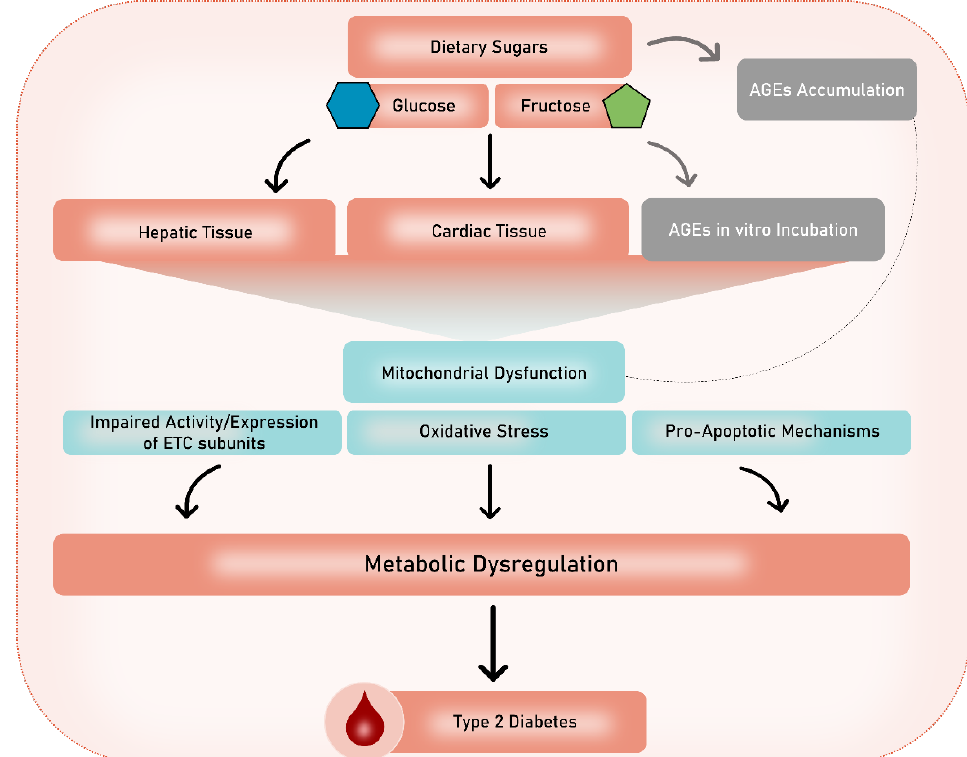
Figure 2. Increased intake of dietary sugars (mainly glucose and fructose) leads to mitochondrial dysfunction. Mitochondrial dysfunction across hepatic and cardiac tissue triggers metabolic dysreg- ulation, including insulin resistance, which ultimately induces the development of type 2 diabetes. In parallel, it is hypothesized that advanced glycation end-products (AGEs) accumulation induced by higher consumption of dietary sugars could lead to mitochondrial dysfunction, through AGEs receptors (RAGEs) activation. Evidence shows that in vitro incubation of different cell lines either with AGEs precursors or AGEs, results in mitochondrial dysfunction, which could act as a starting point to induced metabolic dysregulation and induces type 2 diabetes development.